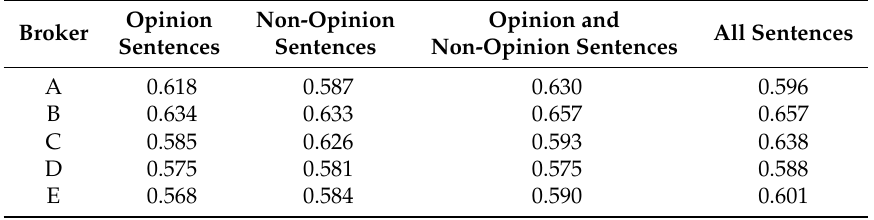
Table 7. Summary by broker in forecasting volatiles with our method. Macro-F1 is a